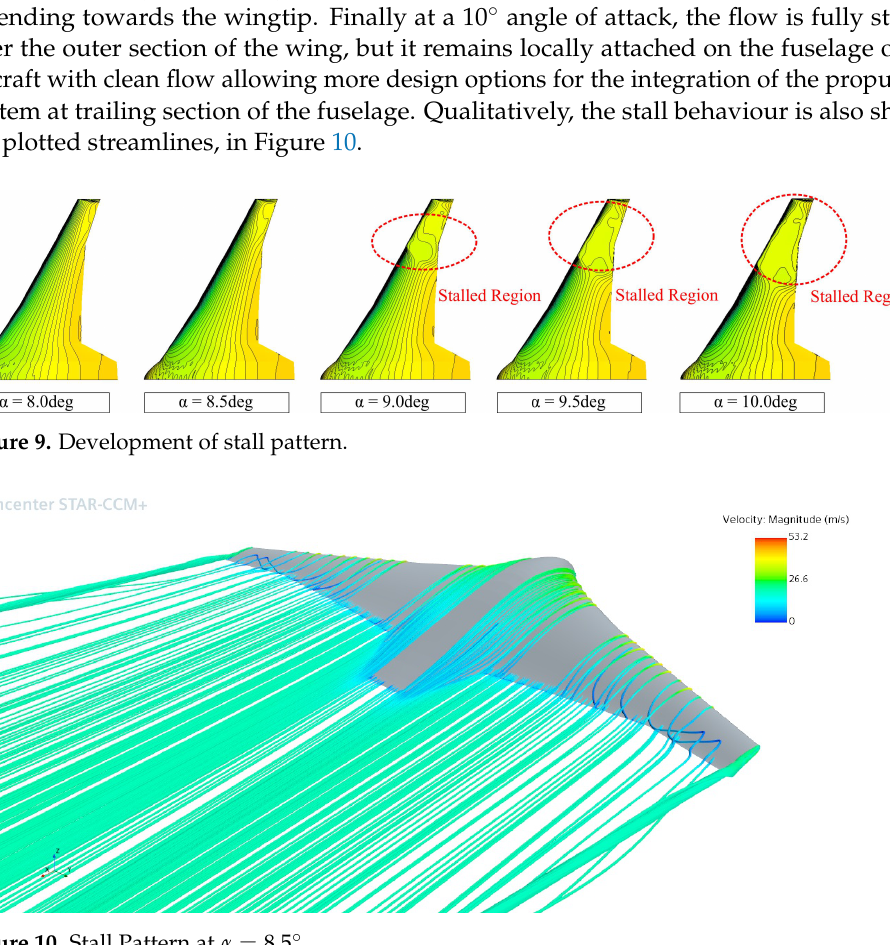
Figure 10. Stall Pattern at α = 8.5 ◦